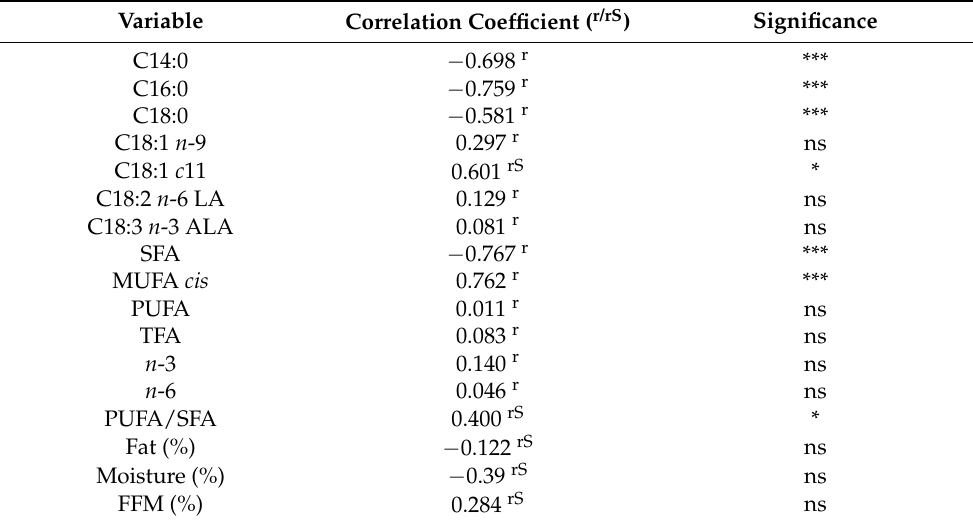
Table 6. Correlations between the body weight and bone marrow